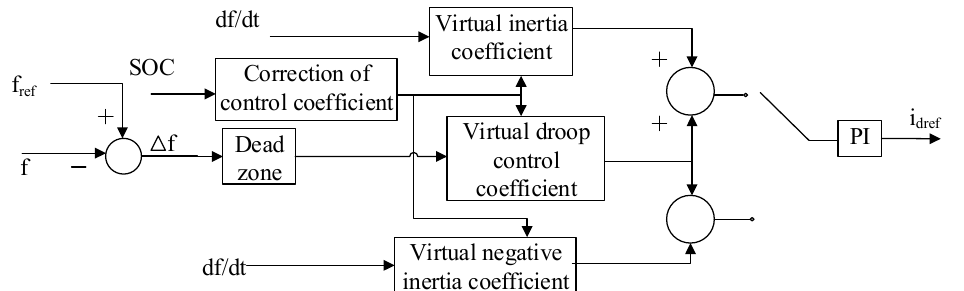
Figure 4. Block diagram of the integrated control strategy.